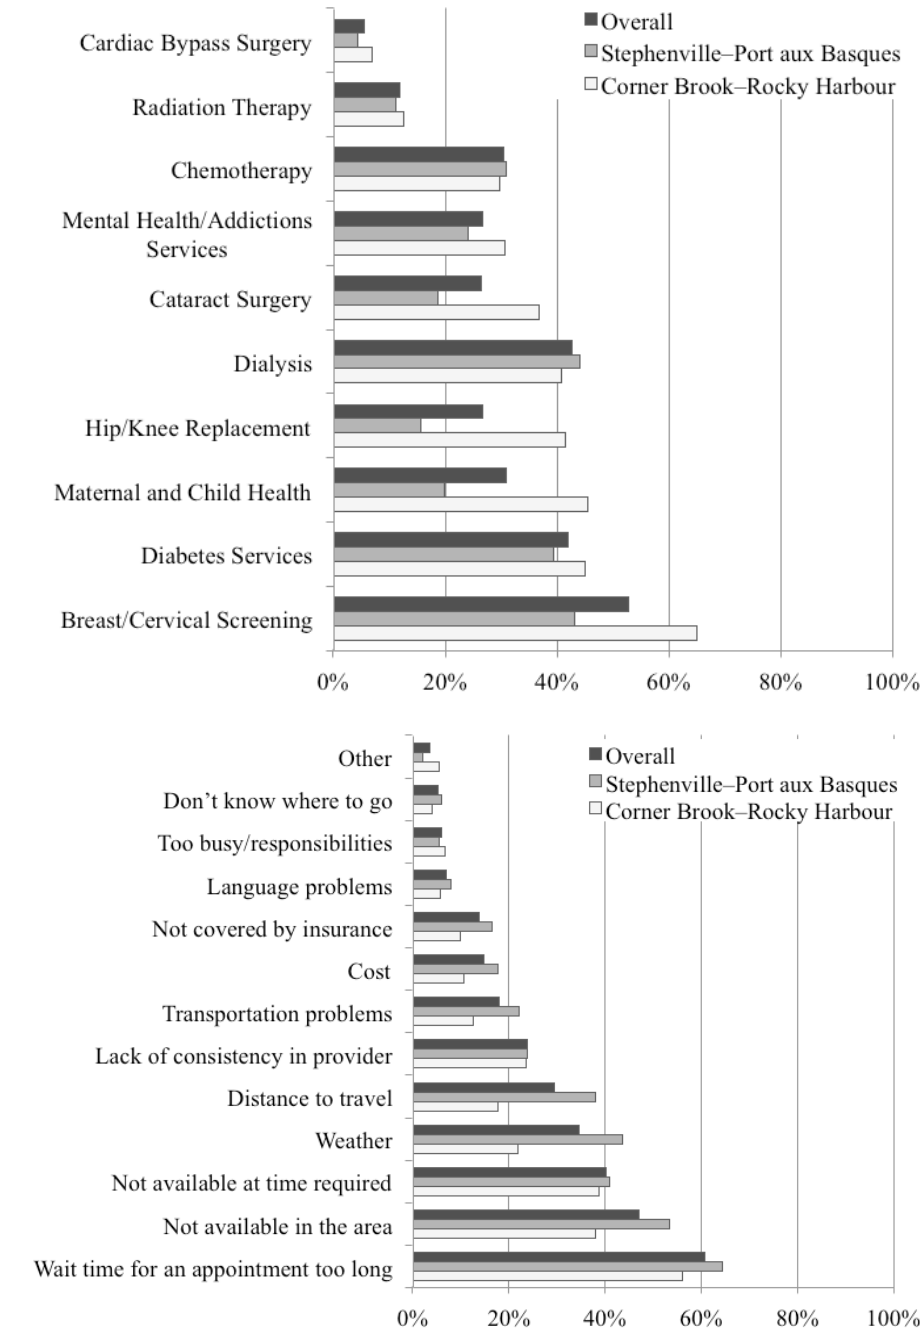
Figure 5: Barriers